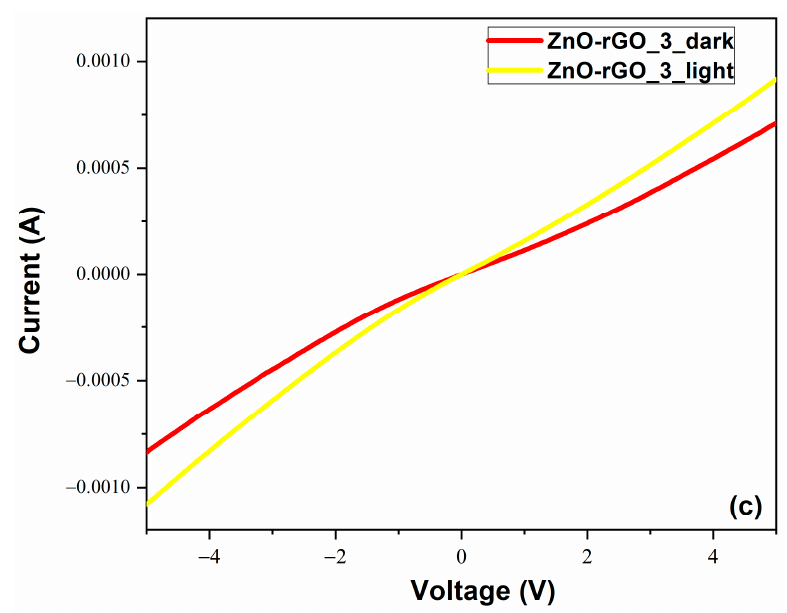
Figure 15. Measurement I–V (current–voltage) curves in dark and with UV light thin films of ( a ) ZnO and ZnO-rGO_1, ( b ) ZnO-rGO_2 and ( c ) ZnO-rGO_3.